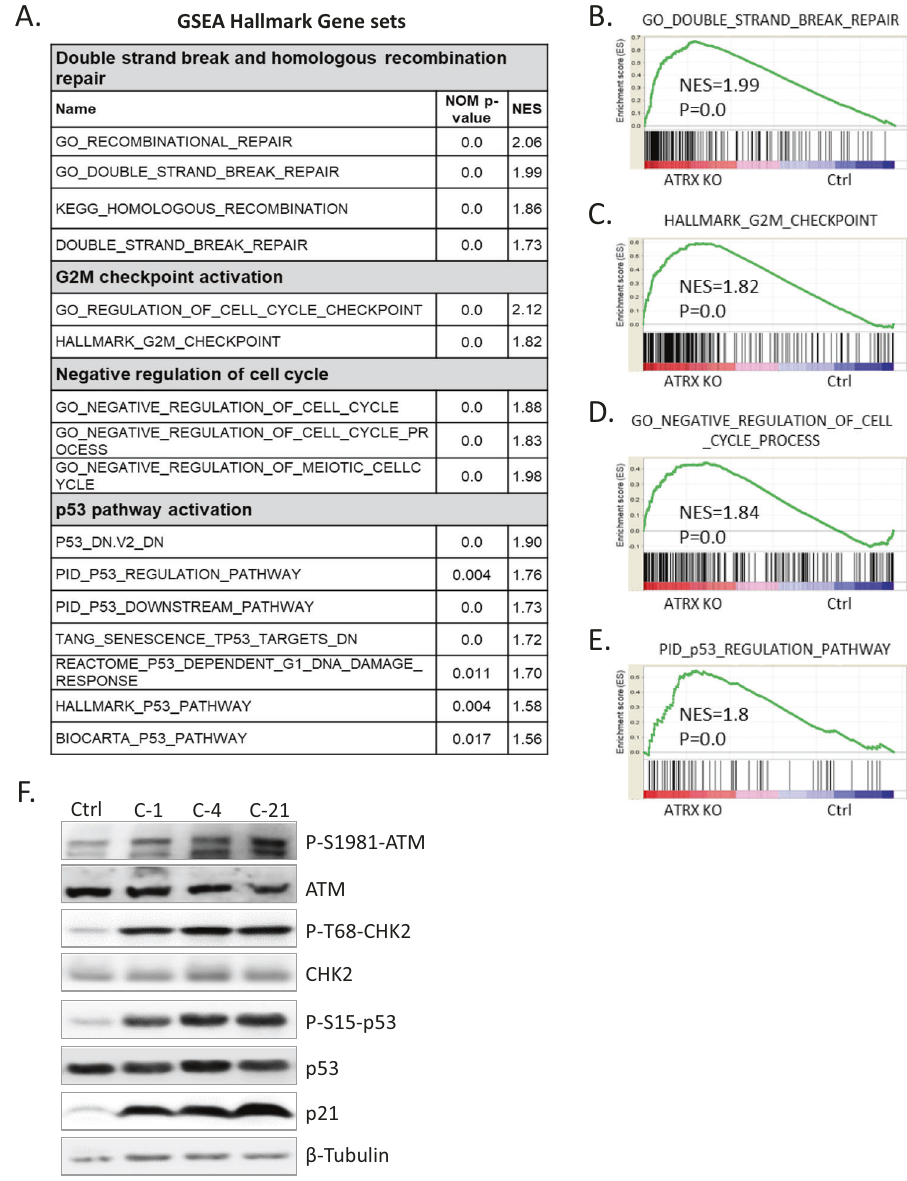
Fig. 2 Increased DNA damage leads to ATM/CHK2/p53 pathway induction in ATRX KO NGP cells. A The Gene Set Enrichment Analysis (GSEA) results of differentially expressed gene sets between Ctrl and ATRX KO NGP cells. Collected nominal p-values and normalized enrichment scores (NES) were listed. B – E GSEA enrichment plot. The gene sets of B ‘ GO DOUBLE STRAND BREAK REPAIR ’ , C ‘ HALLMARK G2M CHECKPOINT ’ , D ‘ GO NEGATIVE REGULATION OF CELL CYCLE PROCESS ’ , and E ‘ PID p53 REGULATION PATHWAY ’ were signi fi cantly enriched in ATRX KO NGP cells. F Representative immunoblots for the expression of the indicated proteins in cell lysates prepared from Ctrl and ATRX KO NGP cells. ATRX KO NGP cells showed the increased activation of p53-ATM checkpoint proteins. β -Tubulin was used as a loading